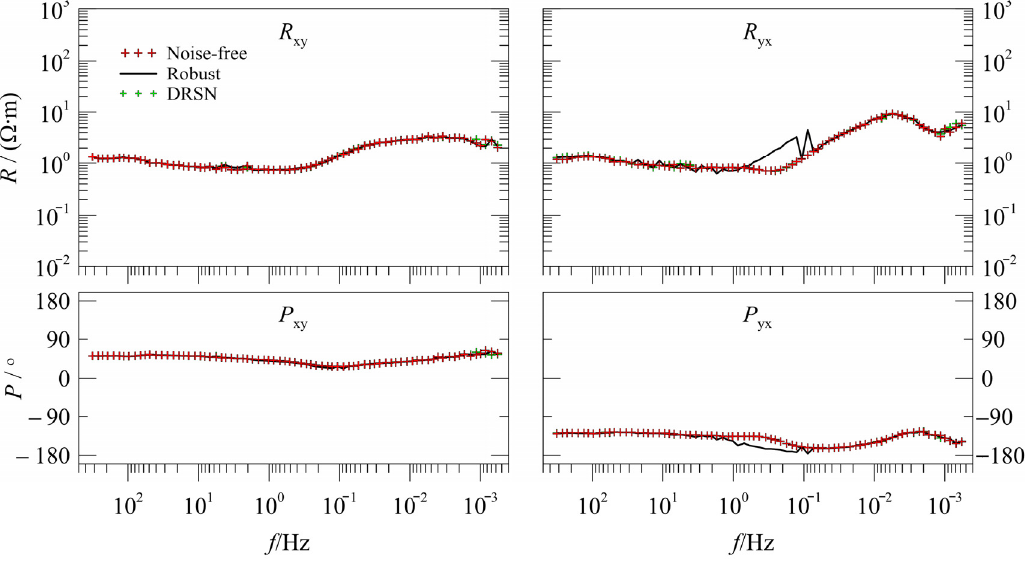
Figure 17. The ( upper panels) are apparent resistivity curves, and the ( bottom panels) are phase curves denoised by DRSN and the robust method.